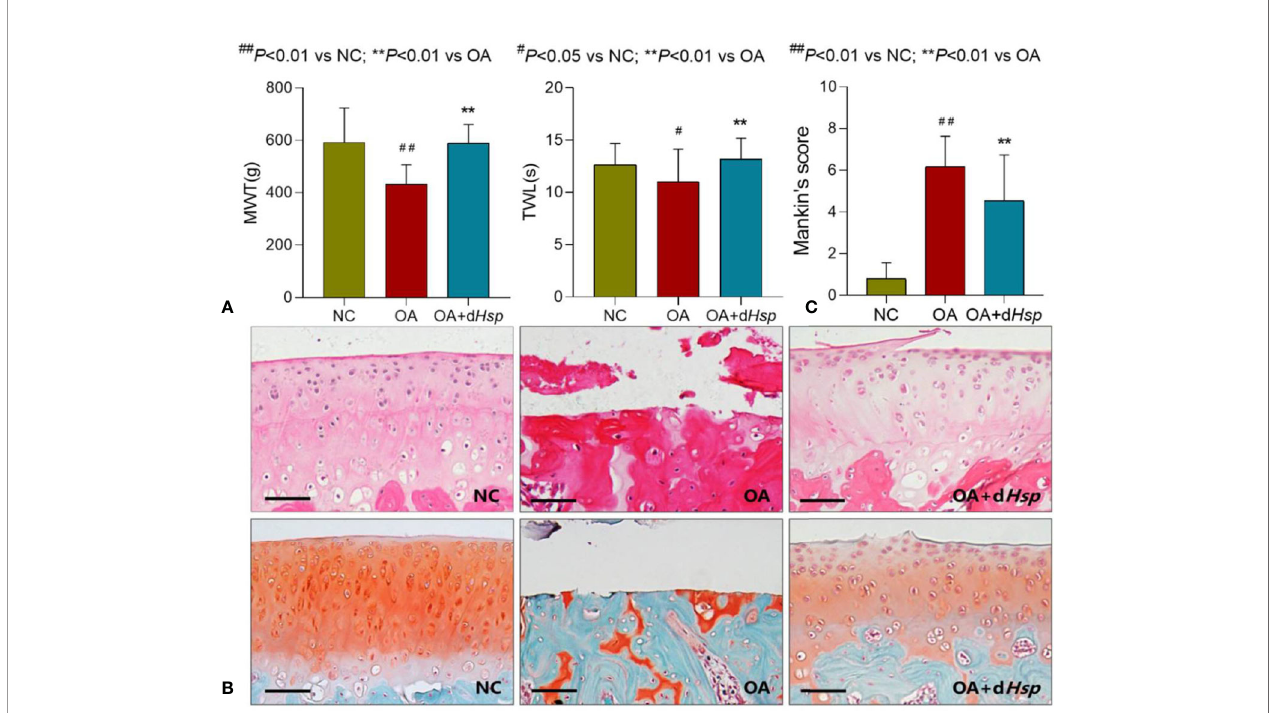
FIGURE 4 | (A) MWT (g), TWL (s) results of the left and right hind paws of rats tested after fi nal d Hsp treatment (28 d); (B) Histopathological observation (HE and Safranin-O staining); (C) Mankin ’ s scoring of rat knee joints at day 28 after d Hsp treatment. Values are presented as mean ± SD. # P < 0.05 vs. NC group; ## P <0.01 vs. NC group; ** P <0.01 vs. OA group. Scale bar = 100 m